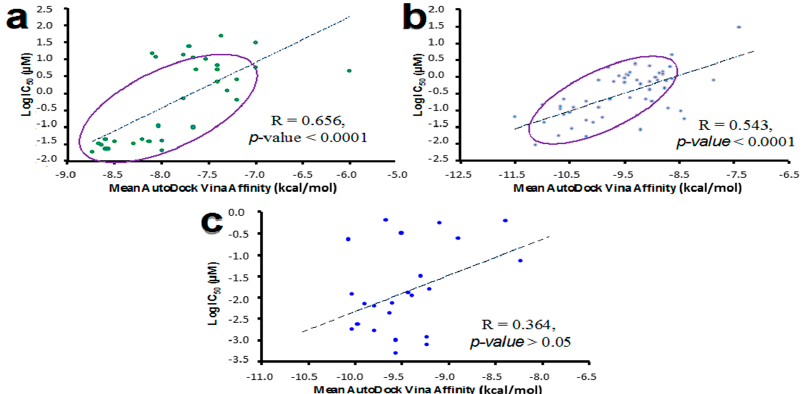
Figure 6. Correlation analysis between calculated Affinity values (kcal/mol) for known HER inhibitors and the logarithm of their half maximal inhibitory concentration (Log IC 50 ). HER1, 2ITW ( a ); HER2, 3PP0 ( b ); and HER4, 2R4B ( c ). HER3 was not evaluated because no quantitative information was available for its inhibitors. It is known that HER3 lacks several residues that are critical for